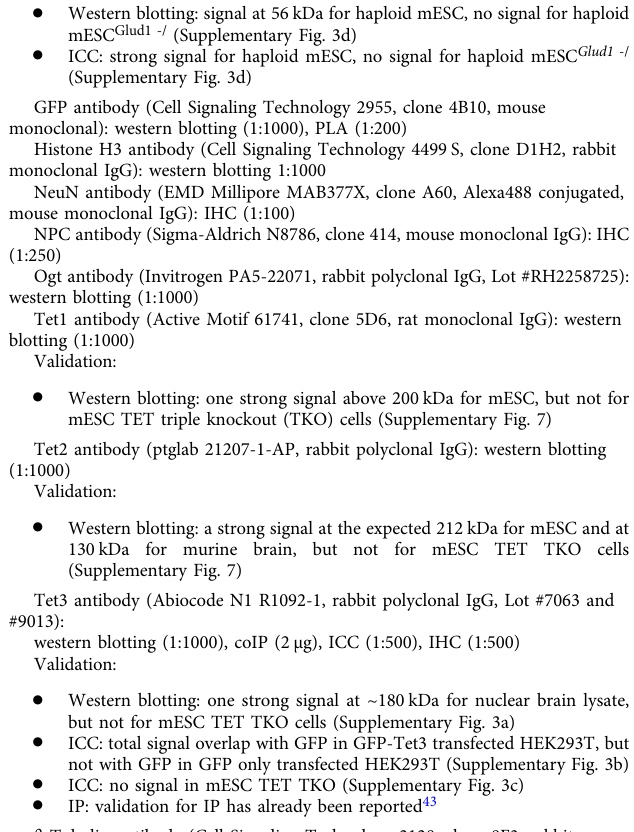
● Western blotting: signal at 56kDa for haploid mESC, no signal for haploid mESC Glud1 -/ (Supplementary Fig. 3d) ● ICC: strong signal for haploid mESC, no signal for haploid mESC Glud1 -/ (Supplementary Fig. 3d) GFP antibody (Cell Signaling Technology 2955, clone 4B10, mouse monoclonal): western blotting (1:1000), PLA (1:200) Histone H3 antibody (Cell Signaling Technology 4499 S, clone D1H2, rabbit monoclonal IgG): western blotting 1:1000 NeuN antibody (EMD Millipore MAB377X, clone A60, Alexa488 conjugated, mouse monoclonal IgG): IHC (1:100)